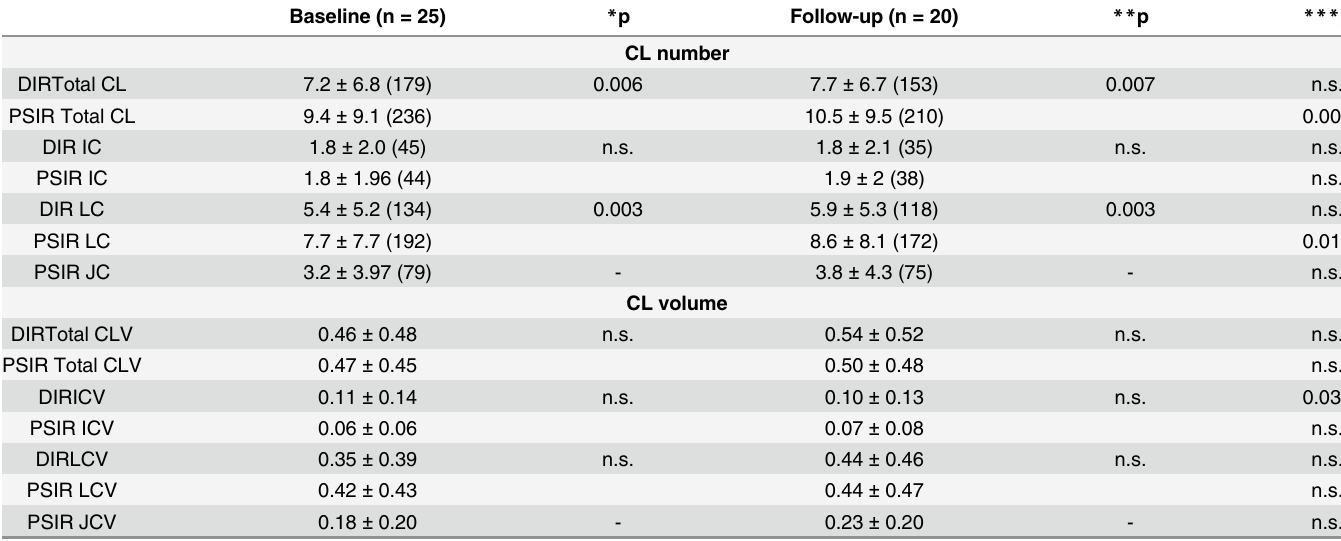
Table 2. Baseline and follow-up cortical lesion volumes and counts in patients with primary progressive multiple sclerosis.